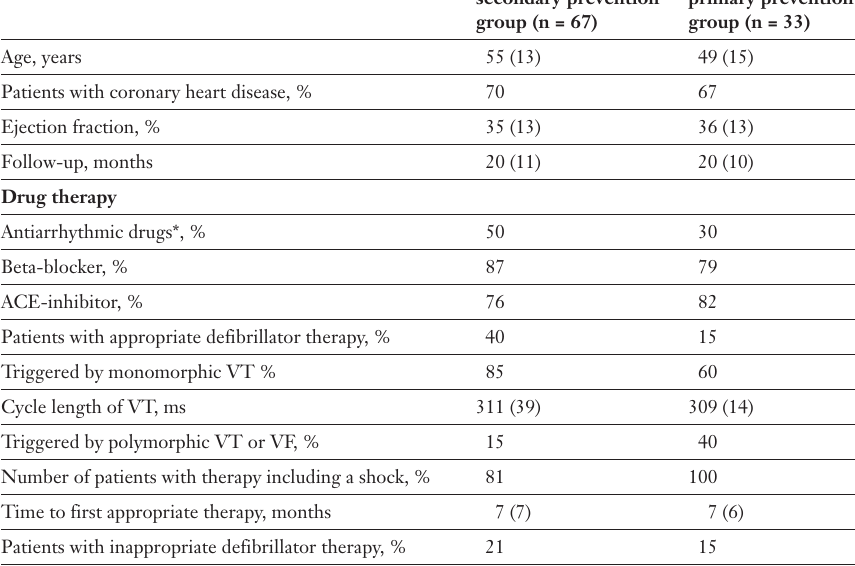
Table 1 Characteristics of the patients according to the indication for defibrillator implan-